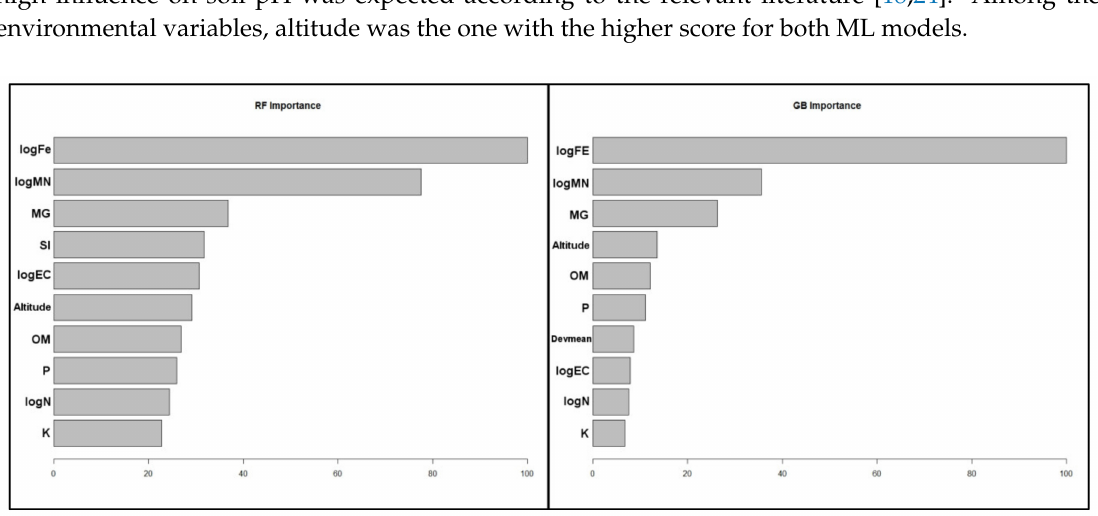
Figure 6. Relative importance of covariates (random forests on the left and gradient boosting on the